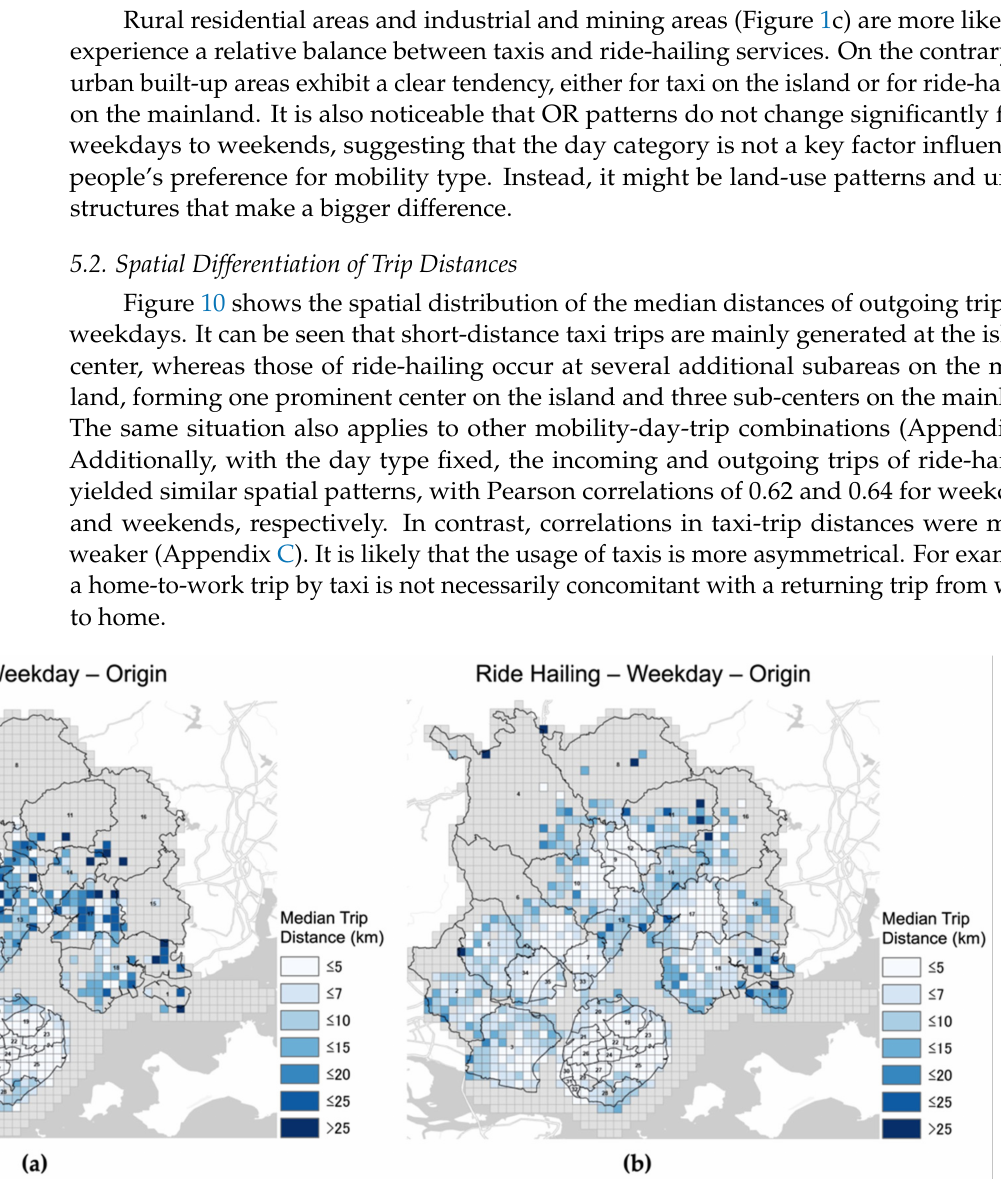
Figure 10. Median distances (km) of outgoing trips of taxi ( a ) and ride-hailing ( b ) on weekdays. The distance–decay effect is calculated as the probability of trips that can reach a certain distance. As shown in Figure 11, the day category has no significant impact on the distance decays. In contrast, it is the mobility type that matters. Hence, trips observed from taxi services always decayed faster than those from ride-hailing within 8 km. For distances larger than 8 km (upper quartile of ride-hailing trip distances on weekends), the probability for both mobility types became small but